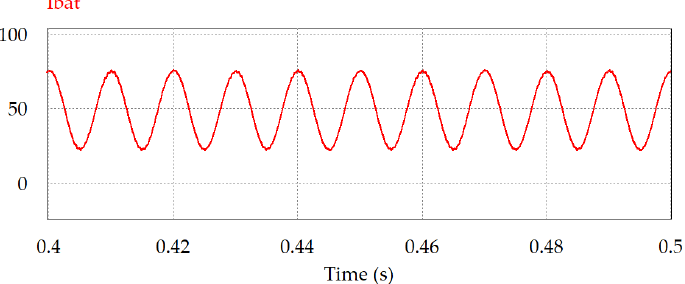
Figure 21. Simulation results of operation mode 2, the voltage across input capacitor V C voltage V DC _ bus / 10.